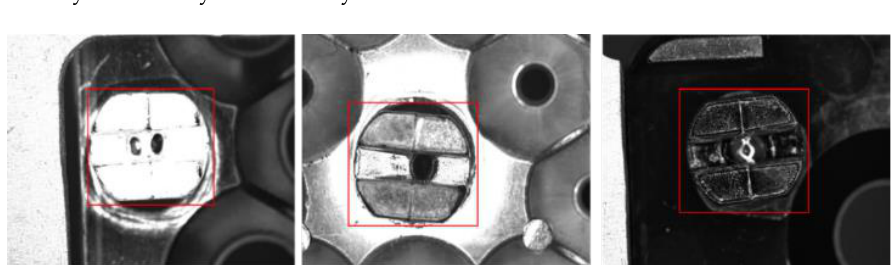
Figure 1. Different buckle types (buckles are inside the red